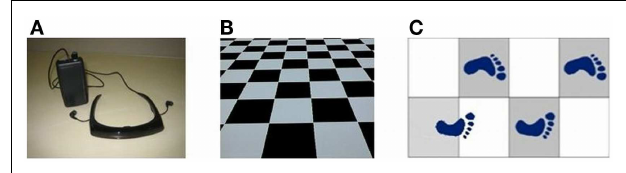
FIGURE 2 | (A) Sensory feedback apparatus. (B) Glide-symmetric tile pattern displayed by apparatus. (C) Gait regulation by visual feedback.